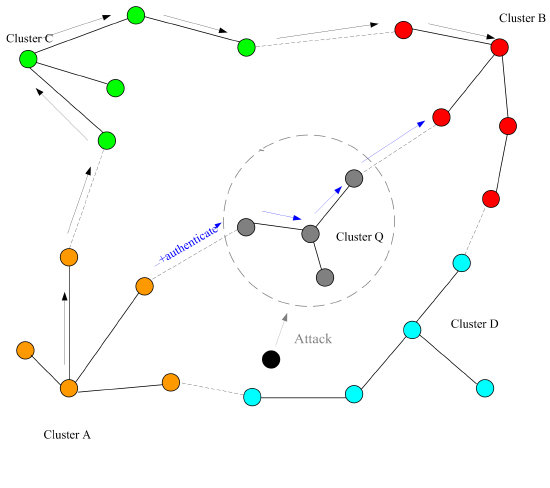
Figure 13. Authentication of quarantine process for clusters (Case I).